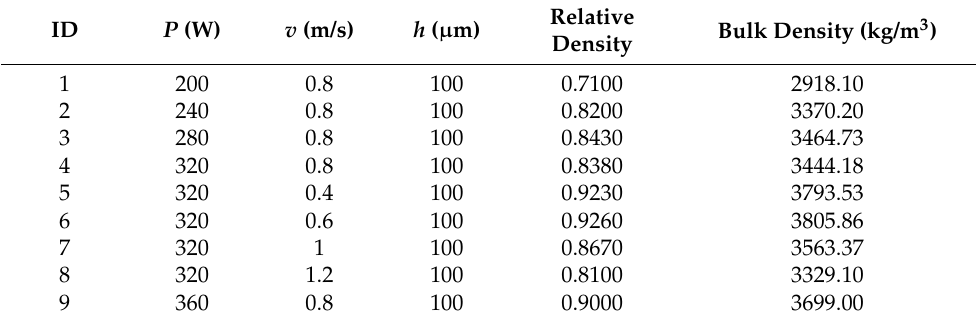
Table A15. Manufacturing parameters and experimental data adapted from [29]. Complement- ing relevant information and assumptions are the following; material: TiSiC, theoretical density